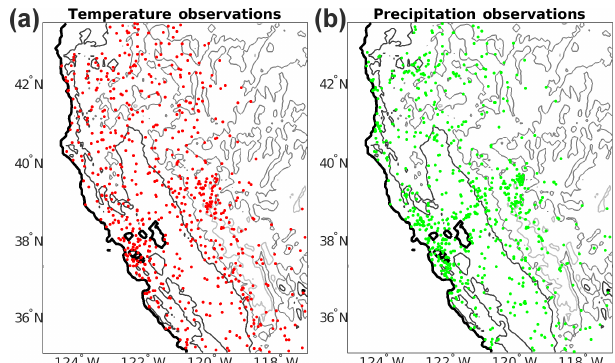
Figure 6. The TIER test domain with (a) the temperature station distribution and (b) the precipitation station distribution. Contours indicate the 0, 500, 1500, and 2500m elevation contours moving from black to light